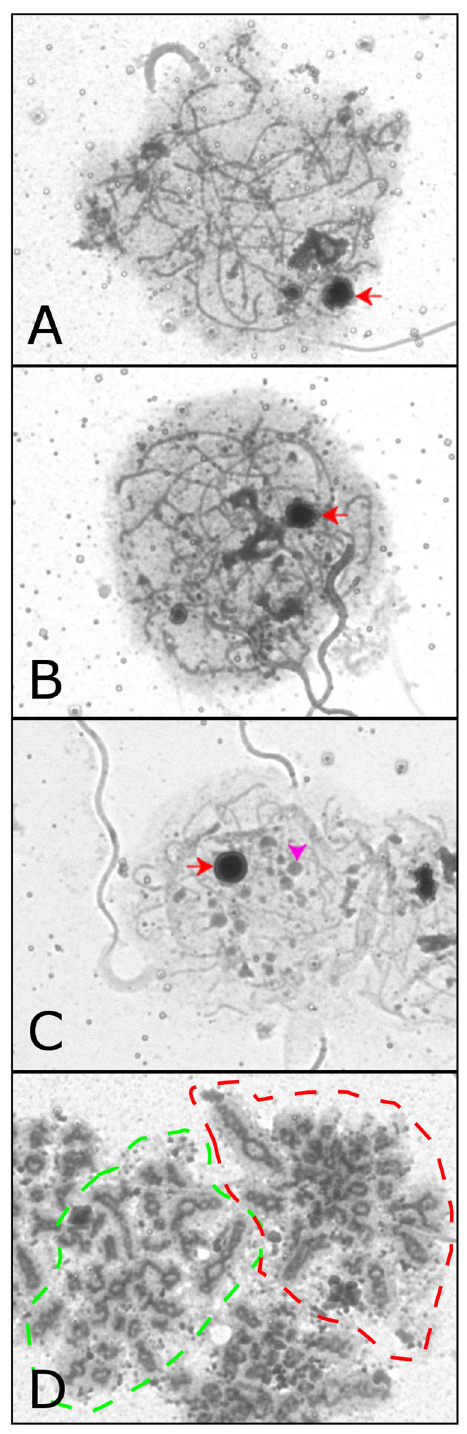
Figure 2. Silver staining of platypus pachytene cells. From zygotene ( A ) to diplotene ( C ) there is a heavily stained large spherical structure that is the nucleolus (red arrow). In diplotene many smaller spherical bodies are visible, usually four larger bodies (examples marked with large pink arrowheads) and numerous smaller bodies (examples marked with small pink arrowheads). By diakinesis ( D ) (two cells are outlined by red and green dashes), there is no obvious nucleolus and the axial core clearly has significant protein recruitment, having a darker core than seen in any of the other stages. Scale bar = 10 µ